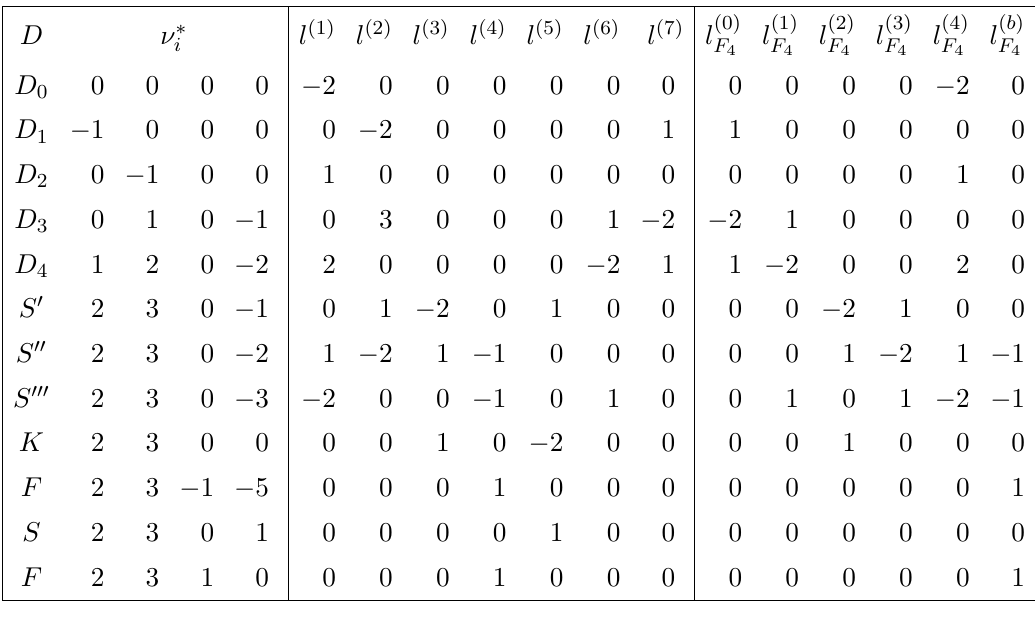
Table 2 . The toric data of P (cid:1) for G = F 4